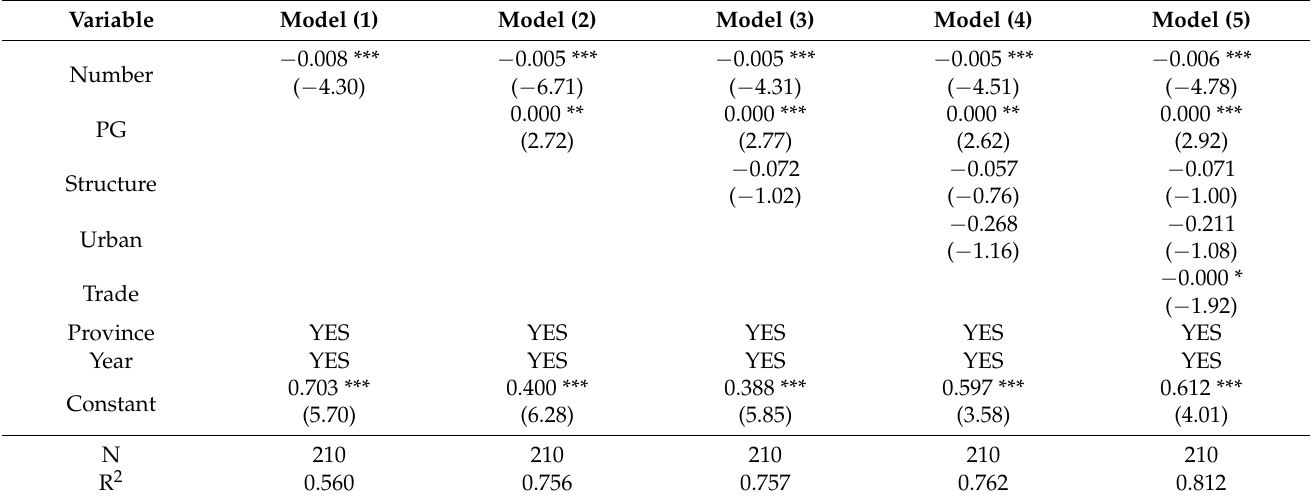
Table 4. Static panel test results